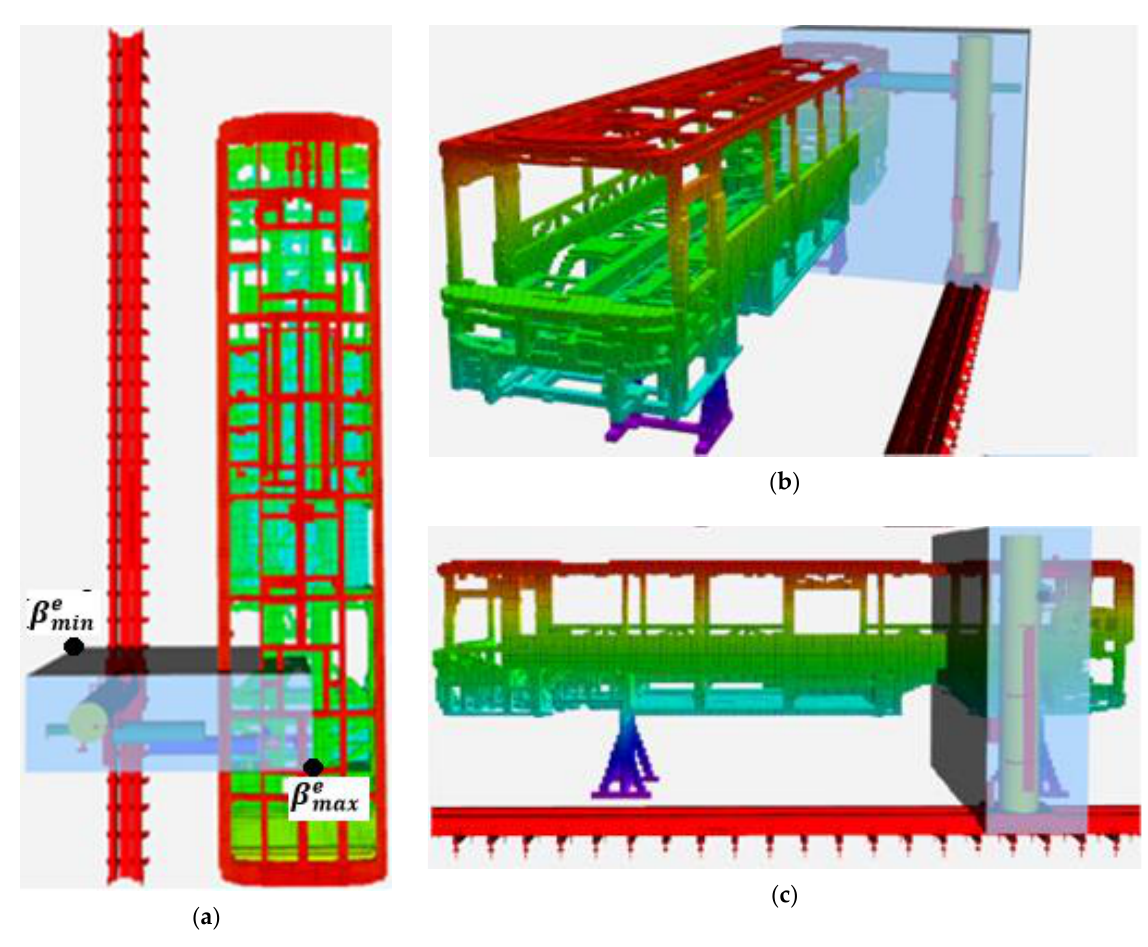
Figure 9. Demonstration of cylinder representation of the robot, volumetric map of the environment, and the minimum bounding box from different perspectives: ( a ) Top view, ( b ) cross view, ( c ) side view.